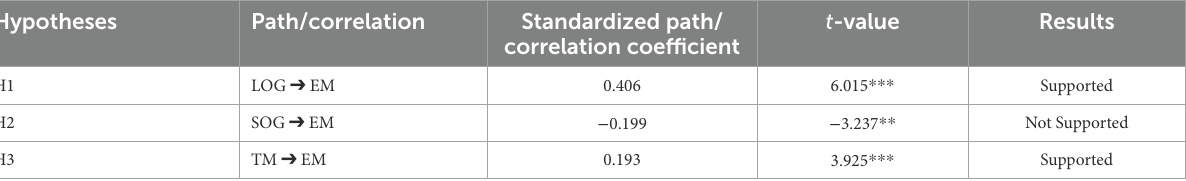
TABLE 2 Hypothesis testing